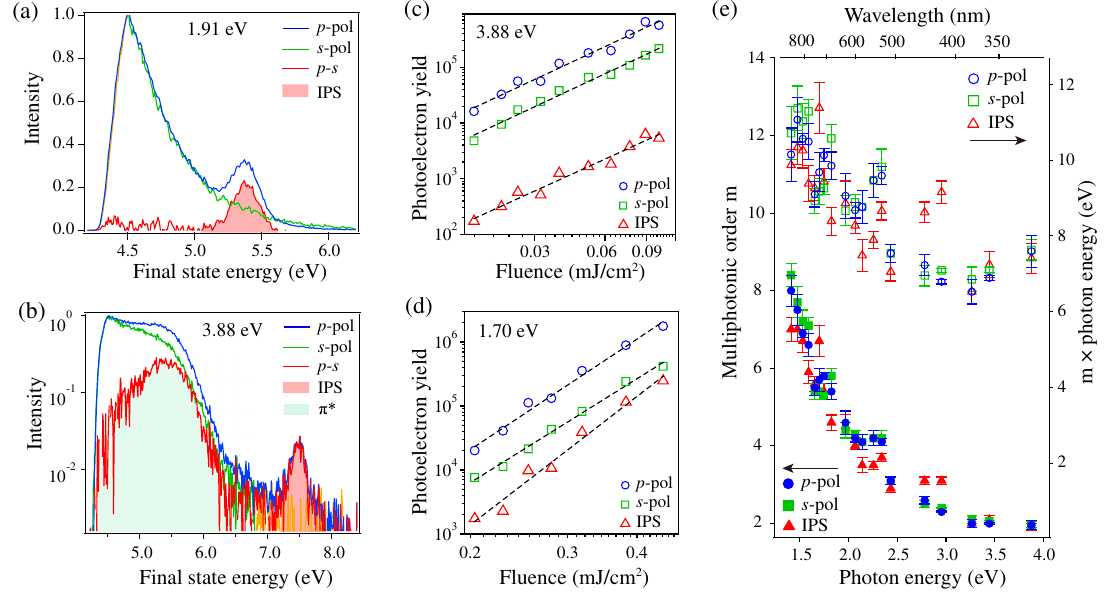
FIG. 3. Identification of different spectral components contributing to mPP spectra and their nonlinear order. (a) Normalized mPP spectra obtained with p polarization (blue) and s polarization (green) for h ν ¼ 1 . 91 eV. The difference spectrum between the p - and s -polarized spectra (red curve) isolates the IPS (pink). (b) Normalized mPP spectra obtained with p -polarized (blue) and s -polarized (green) light for h ν ¼ 3 . 88 eV and their difference representing photoemission from the π (cid:1) state (aquamarine) and IPS (pink). (c) The photoelectron yields with increasing laser fluence obtained by integrating the photoelectron counts for p -polarized (blue) and s -polarized (green) excitation. For IPS, the photoelectron yield is integrated from the pink area in the difference spectra such as in (a). The log-log plots give slopes of 1.96, 1.97, and 1.91 for the p, s, and IPS spectra, respectively, corresponding to the nonlinear order of m ∼ 2 . (d) The same plot as in (c) for h ν ¼ 1 . 70 eV; the obtained slopes are 5.74, 5.40, and 6.68 for the p, s, and IPS spectra, respectively, corresponding to m ∼ 6 . (e) Left axis: The multiphotonic order m for the p - and s -polarized spectra, as well as the IPS component vs h ν (solid symbols). Right axis: The total photon energy absorbed ( mh ν ) that is required to photoemit an electron from graphite vs h ν (hollow